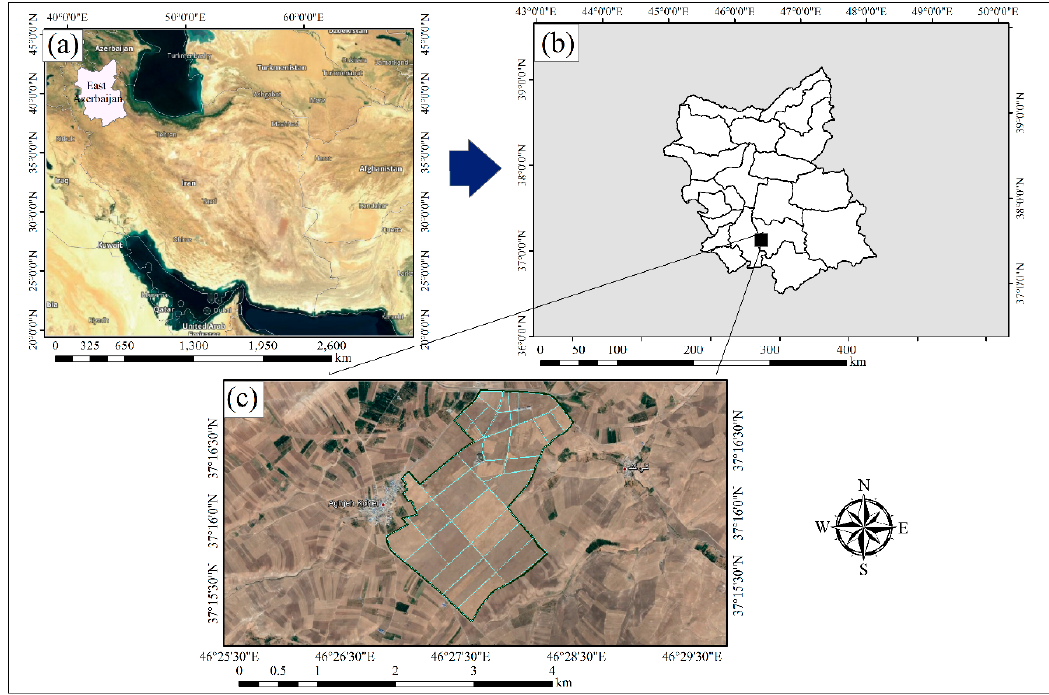
Figure 1. Location maps of study site: ( a ) map of Iran, ( b ) map of East Azerbaijan province, and ( c ) map of the experimental fields operated by the Dryland Agricultural Research Institute (Aghjeh Kohel village).